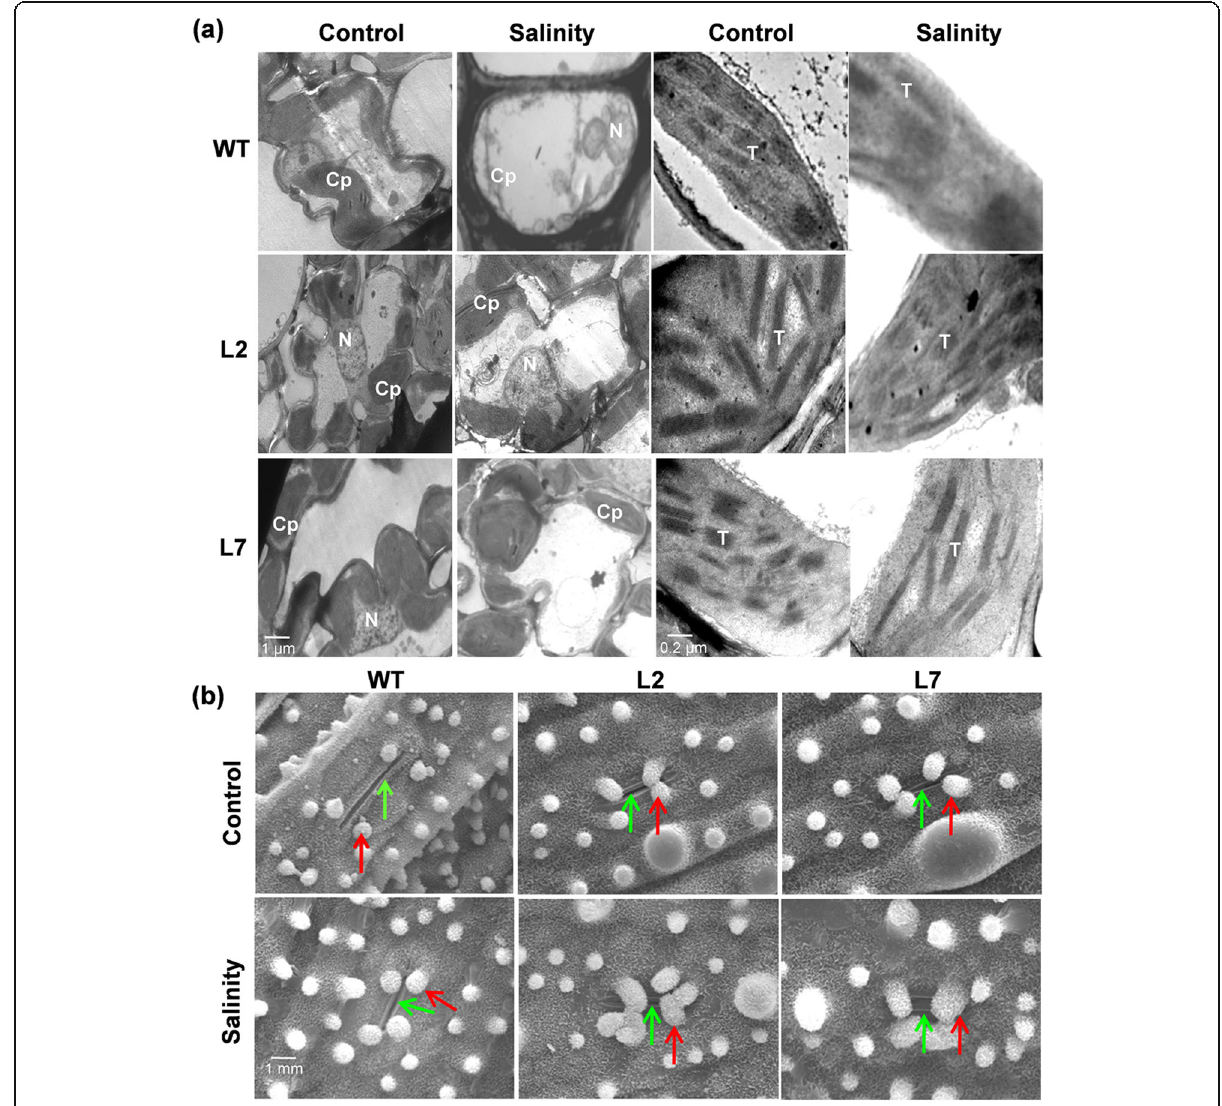
complete cell of WT (1st row) and OsHBP1b over-expressing plants (2nd row) under control (1st column) and after 200 mM NaCl treatment (2nd column) as observed under TEM. Third and fourth column are showing the structure of a single chloroplast and organisation of thylakoid under control and salinity conditions in WT and over-expressing plants. b SEM picture showing the structure of stomata in WT and OsHBP1b over-expressing plants under control and salinity stress. Note that under salinity, the stomata of OsHBP1b over-expressing plants are protected. Cp, chloroplast; N, nucleus; T, thylakoid. Green and red arrows indicate stomata and silica cell